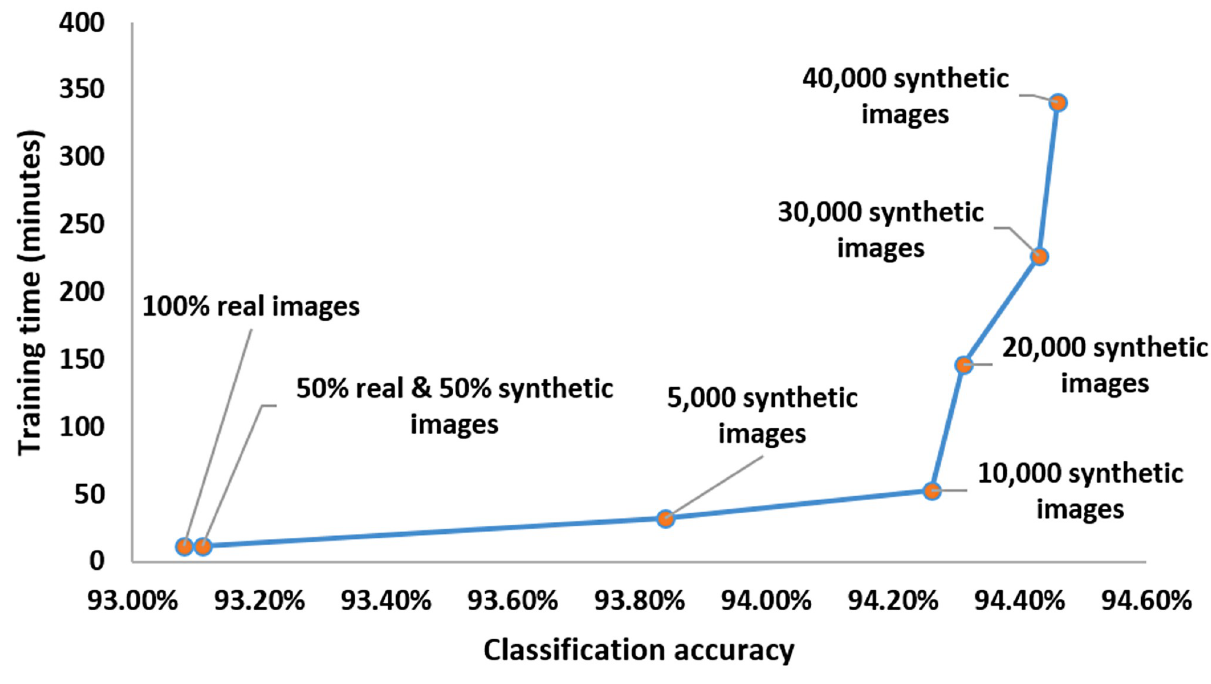
Fig 15. Classification accuracy Vs training time trade-off.